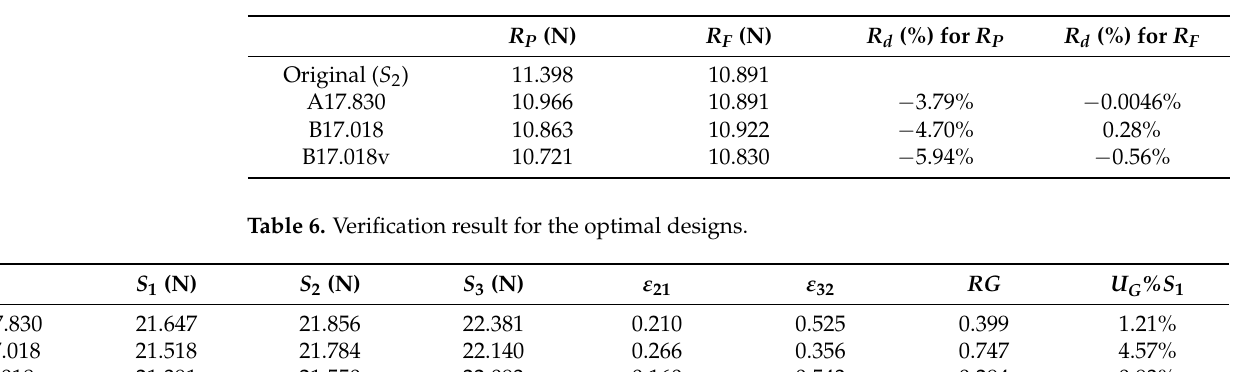
Table 6, so the results can be considered validated. Table 5. Comparison of resistance components for different sonar dome configurations.